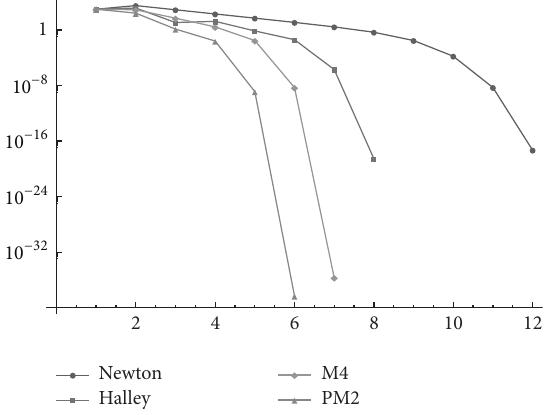
Figure 5: Convergence history based on the logarithm of the residuals ‖𝑋 2 𝑘 − 𝐼‖ ∞ in Example